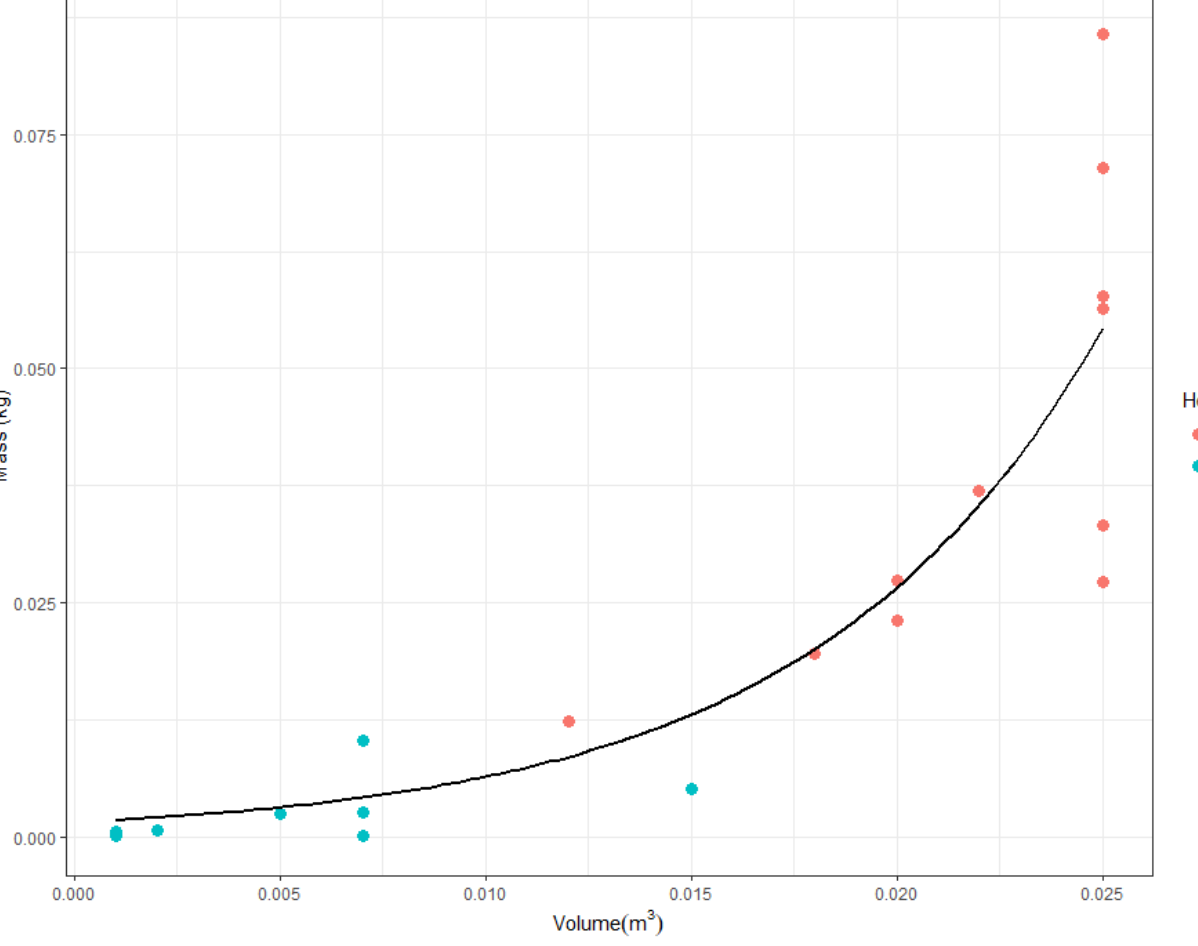
Figure 5. Exponential, nonlinear regression for woody litter fuel material with both volume and height as predictors of mass. Only mass and volume observations associated with the strata between 0 and 20 cm were included. Using this equation, loading was calculated for each plot pre-fire using both the voxelized volume and height (Figure 3). The median (±IQR) fuel consumption was 19.83 ± 4.01 g (Table 3). For the paired plots, the median (±IQR) fuel consumption was 20.83 ± 4.53 g (Table 3).